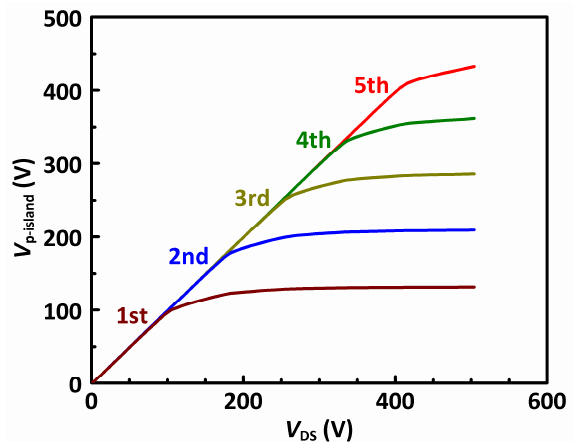
Figure 4. The voltage of the 1st to 5th p-island from top to bottom in the proposed MOSFET vs. V DS in off-state.